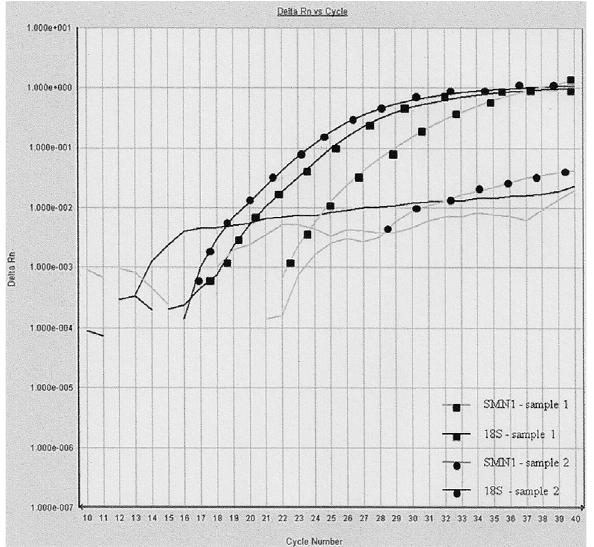
Figure 1 - TaqMan ® assay for the SMN1 gene. Sample 1 is DNA from an individual with the SMN1 gene, showing both SMN1 gene and eukaryotic 18S rRNA gene amplification. Sample 2 is DNA from a patient with a de- letion of SMN1 (indicative of SMA) showing only amplification of the eukaryotic 18S rRNA gene. Remaining lines with no amplification repre- sent the negative control.